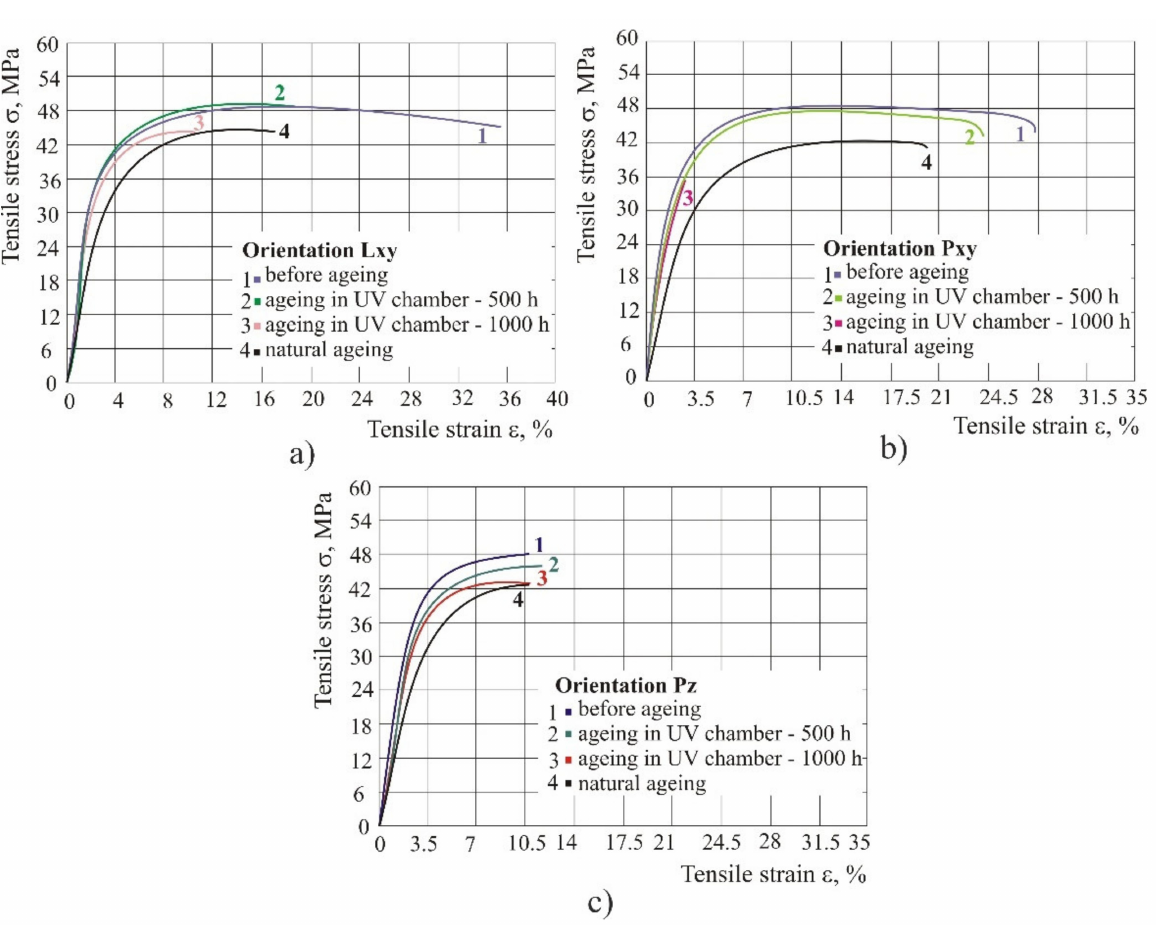
Figure 5. The diagram of tensile stress–strain of test specimens with the use of original material in case of UV radiation: ( a ) orientation Lxy, ( b ) orientation Pxy, ( c ) orientation